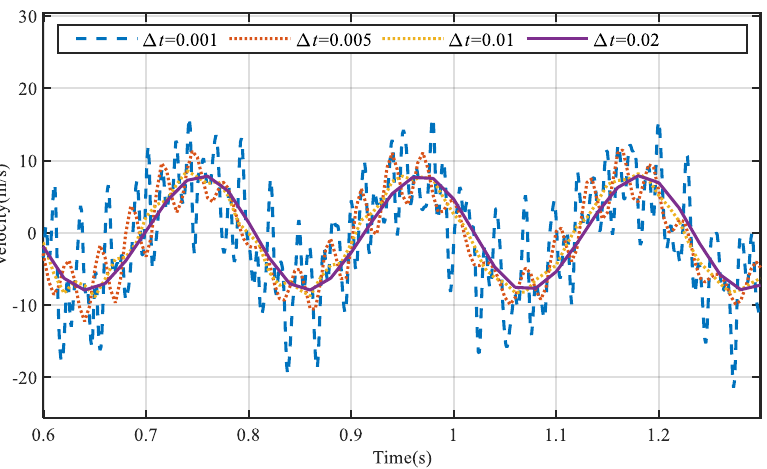
Figure 21. Velocity responses of Point A with different time steps.